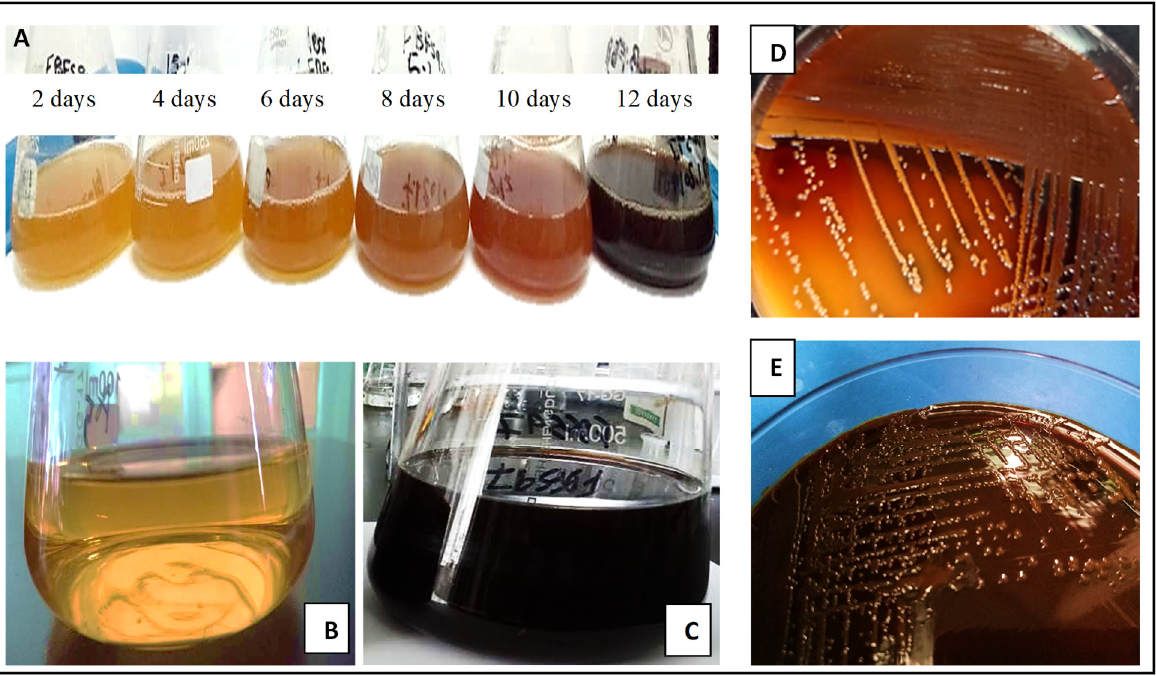
Figure 1. Melanin production by G. oxydans FBFS 97 in glucose yeast extract broth at different elapsed times ( A ), GY broth was used as the negative control ( B ), culture broth after 14 days of incubation ( C ), melanin production on GYC agar plates after 10 days ( D ) and after 14 days ( E ) of incubation.